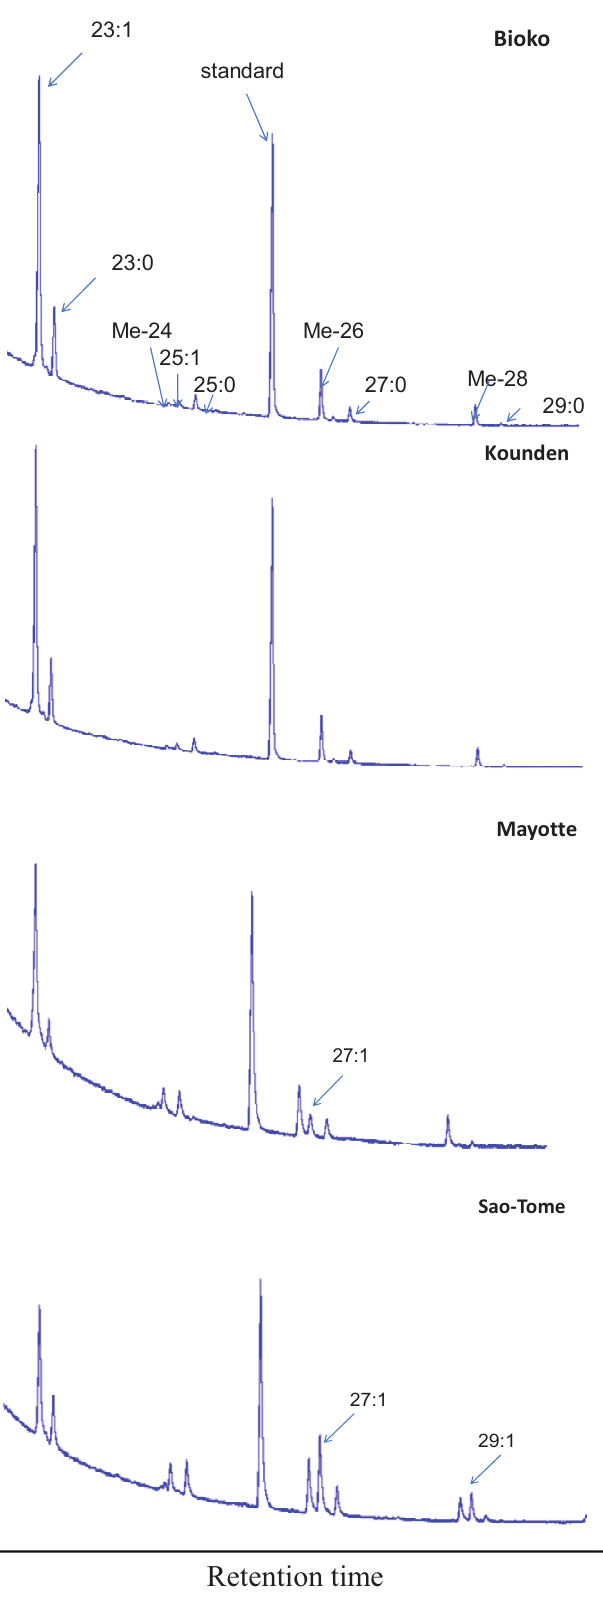
Figure 3. Gas chromatograms of D. yakuba males. 23:1 (tricosenes), 23:0 (tricosane), Me-24 (2-methyltetracosane), 25:1 (pentacosenes), 25:0 (pentacosane), standard (hexacosane), Me-26 (2-methylhexacosane), 27:1 (7-heptacosene), 27:0 (heptacosane), Me-28 (2-methyloctacosane), 29:1 (7-nonacosene), 29:0